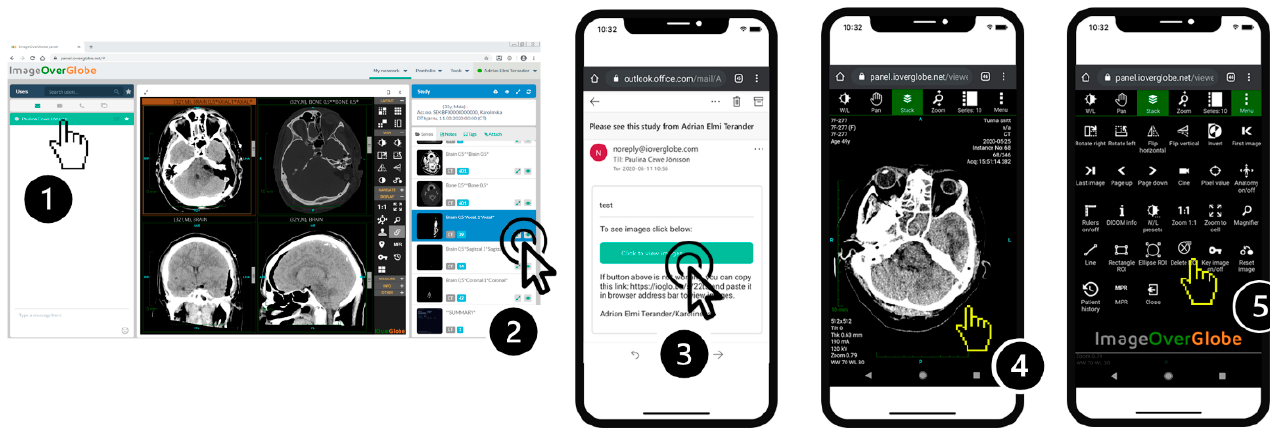
Figure 3. Workflow for remote consultations: Step 1. User selects predefined remote consultant in the application. Step 2. User selects series to be sent anonymized to the consultant through e-mail. Step 3. Consultant receives an e-mail with a URL to the complete set of anonymized series. Step 4. Images are instantly accessed on either SMD or PC. Step 5. Several tools such as measurements, line drawing, MPR-function, are available to facilitate clinical interpretation of lossless im- ages.